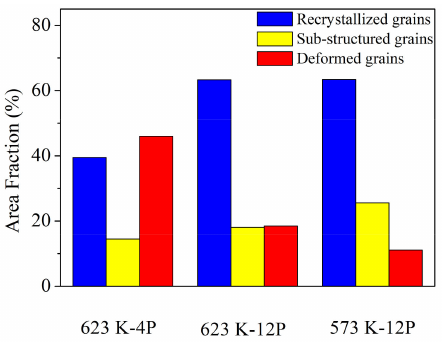
Figure 6. Area fraction of the recrystallized and un-recrystallized grains in three ECAP